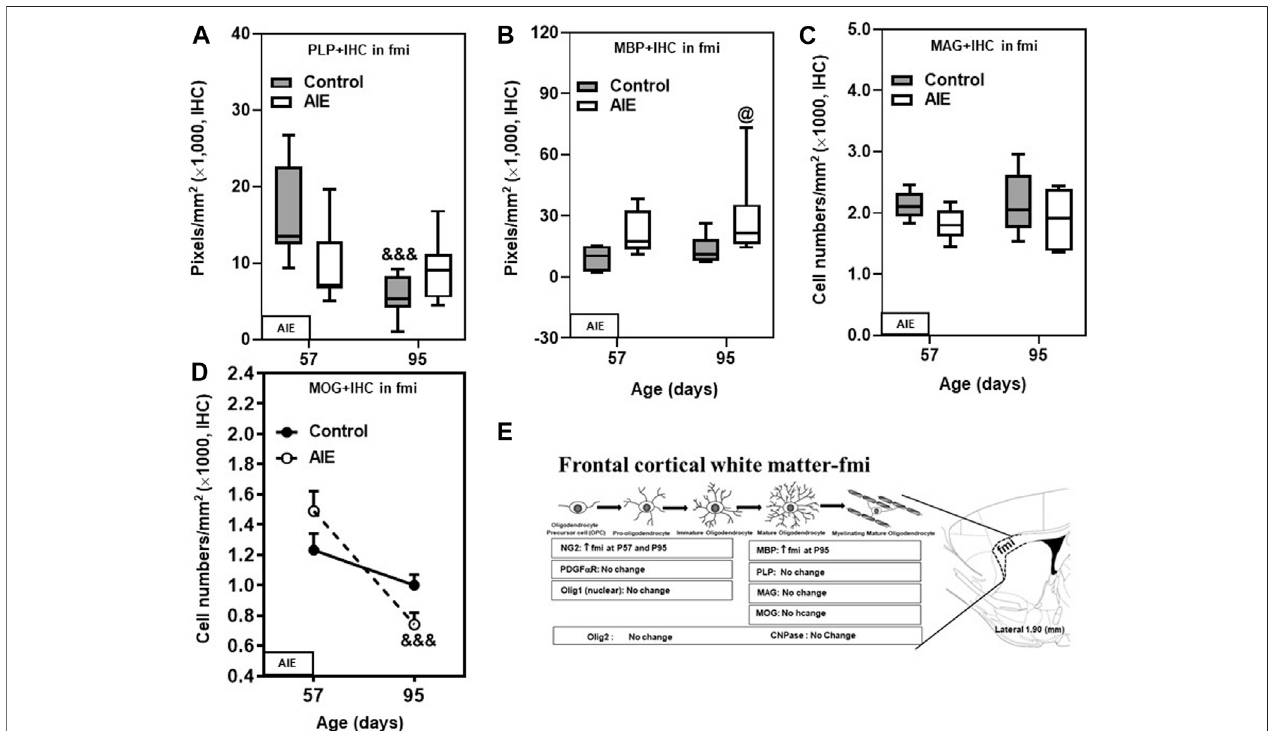
FIGURE3| Effects ofageand AIE on OL markers infrontal corticalwhitematter, theforceps minor ofthe corpuscallosum (fmi). (A) PLP+IHC expression showed maturational decline from P57 to P95 in controls, but not in the AIE group. (B) AIE exposure increased MBP + IHC expression at P95 compared with controls. (C) AIE exposuredidnotaffectMAG+IHCexpression. (D) MOG+IHCexpressionintheAIEgroupshowedmaturationaldeclinefromP57toP95(66%). (E) Schematicdiagram representing the developmental stages of oligodendrogenesis in the fmi. The speci fi c markers that are expressed in distinct stages are indicated below, Arrow “ ↑ ” represents increase; “ ↓ ” represents decease; “ at P57 ” and “ at P95 ” represents at postnatal days 57 and 95 respectively; “ no change ” means that AIE did not affect the markers ’ expression. Rat atlas panel ofthe right sidereprinted from Paxinos and Watson (2014). Datawere expressed as thepixelsofPLP+ (A) and MBP+ IHC (B) and numbers of MAG+ (C) and MOG + IHC (D) positive cells. Each point is mean ± SEM per mm 2 ; n (cid:1) 7 –